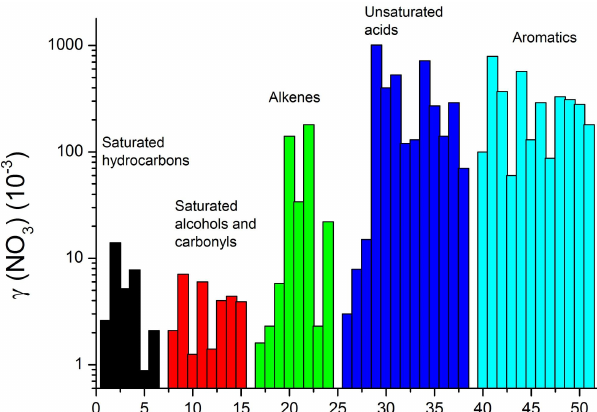
Figure 3. Uptake coefficients, γ (NO 3 ) , for the interaction of NO 3 with single-component organic surfaces. Details of the experiments and the references (corresponding to the x -axis numbers) are given in Table S1 in the